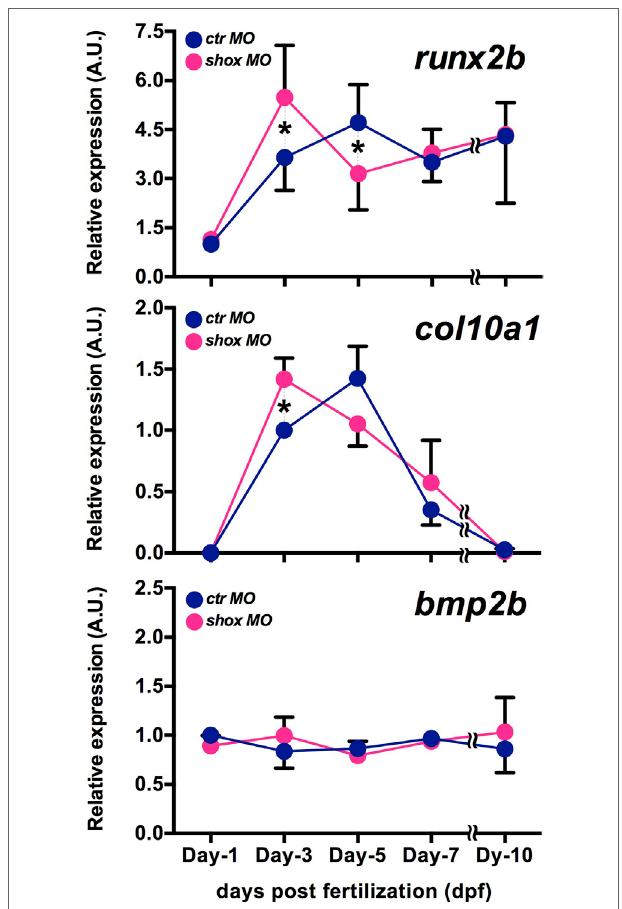
FigUre 2 | Translational blockade of zebrafish shox resulted in precocious expression of bone differentiation markers in developing embryos. Quantitative real-time-PCR analysis of bone differentiation markers ( runx2b , col10a1 , bmp2b ) in morpholino oligo (MO)-injected embryos. Embryos were sampled at 1, 3, 5, 7, and 10 dpf. Transcript levels were normalized to the β -actin level, and the value is shown as relative abundance compared to that of control MO ( ctr MO) at 1 dpf ( runx2b , bmp2b ) or at 3 dpf ( col10a1 ). Data are mean ± SEM, 4–6 independent experiments. * P <